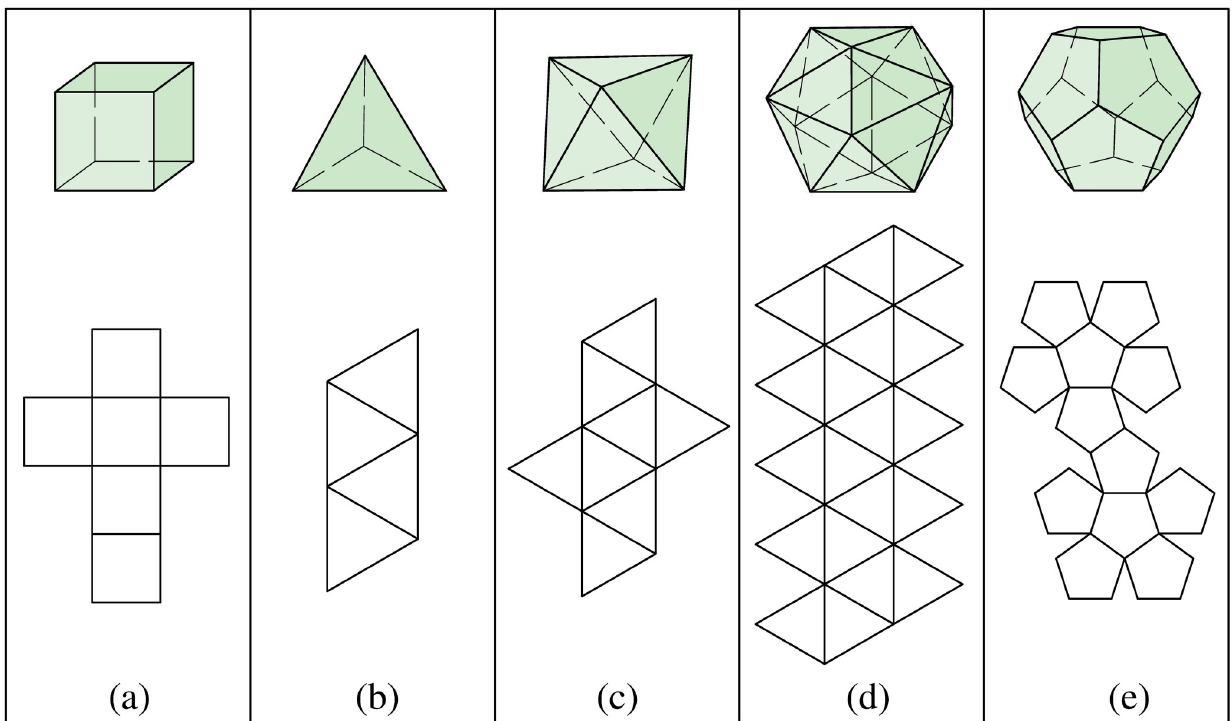
Fig 1. Five models of the Platonic solids and their unfolding geometry. (a) Cube. (b) Tetrahedron. (c) Octahedron. (d) Icosahedron. (e) Dodecahedron.